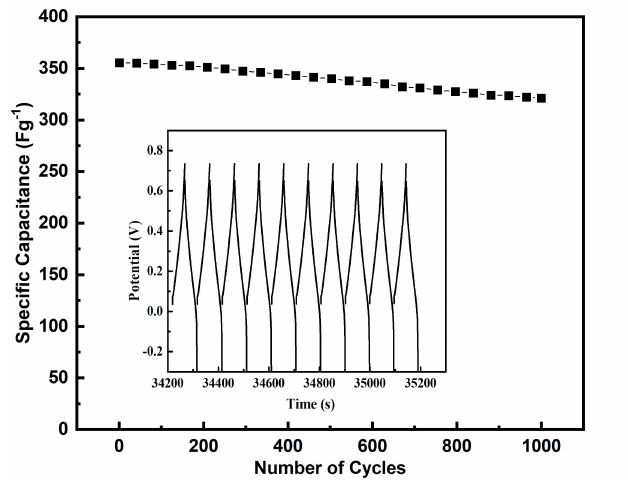
Figure 10. Cycle stability of an FTO-PANI based symmetric supercapacitor over 1000 galvanostatic charge–discharge cycles at 40 Ag − 1 . The inset shows the individual cycles progressing aging stage.